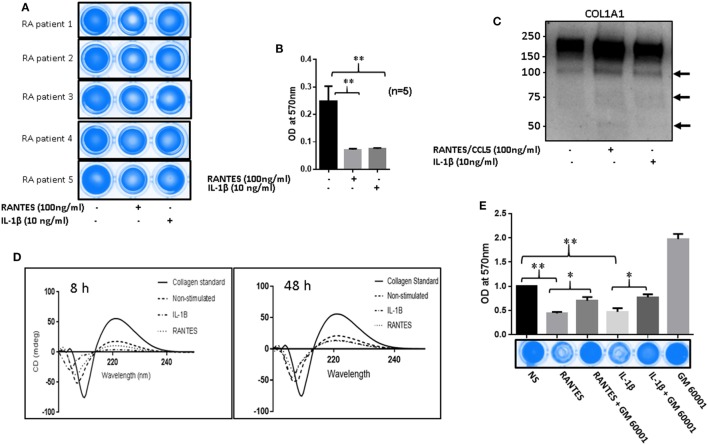
Regulated on activation, normal T expressed, and secreted (RANTES)/CC ligand 5 (CCL5) facilitates matrix metalloproteinases (MMPs)-mediated collagen degradation in rheumatoid arthritis (RA). (A) RA synovial fibroblasts (RASFs) from five donors were stimulated with RANTES/CCL5 (100 ng/ml) and IL-1β (10 ng/ml) for 24 h. Condition media was placed onto a 96-well plate coated with type I collagen film and incubated for 24 h. Plates were stained with Coomassie R250 analyzed by ChemiDoc™ Imager. (B) Optical density (570 nm) of the RANTES/CCL5 and IL-1β-stimulated samples compared to control is shown. (C) Condition media from the same treatment was concentrated using Amicon 10K ultra 0.5 centrifugal filters and analyzed for type I collagen by Western blotting. (D) Condition media from RANTES/CCL-5 or IL-1β stimulated RASFs, was applied on collagen coated 96-well plates for 8 and 48 h. Digested collagen was collected and CD spectroscopy was performed using a Jasco J-815 spectropolarimeter. (E) RASFs were pretreated with GM6001 (20 µM) for 2 h and then stimulated with RANTES/CCL5 (100 ng/ml) or IL-1β (10 ng/ml). Collagen type I plates were exposed for 24 h, media aspirated, and then stained with Coomassie R250 and analyzed as described in Section “Materials and Methods.” Densitometry was performed to show the relative changes. Values are represented as MEAN ± SE from experiments performed using cells from four to five donors. *p < 0.05 or **p < 0.01.